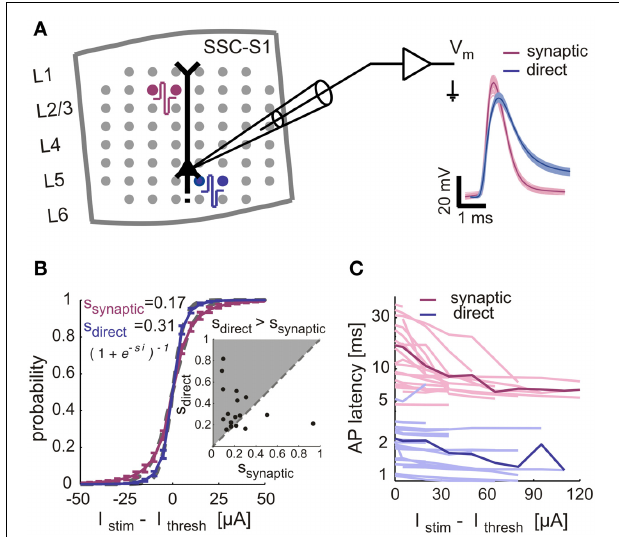
FIGURE 3 | Validation of synaptically and directly evoked neuronal responses across several and within the same neuron in cortical slices. (A) Rat somatosensory cortical slices were coupled on MEAs for extracellular stimulation, during intracellular recordings from large L5 pyramidal cells. Red and blue circles sketch the location of bipolar stimulation sites, eliciting synaptically evoked action potentials (APs) or directly evoked APs (under additional synaptic blockade). Right panel: APs recorded in the same neuron were elicited by synaptic- (magenta) and direct stimulation (blue): waveforms are aligned to their onset, bold lines indicate mean values. (B–C) IO-characteristics in intracellularly recorded neurons in cortical slices. (B) The AP response probability, for increasing stimulus intensity, is summarized across n = 28 experiments performing both direct (blue, n = 20 neurons) and synaptic stimulation (magenta, n = 20 neurons) in the same neurons: gray dashed lines show the best-fit sigmoidal functions. The same fit was repeated cell-by-cell (inset) extracting the sigmoid slope parameters (i.e., ssynaptic, sdirect) and comparing individual experiments ( n = 17 neurons) together (markers), where both stimulation types evoked responses. (C) The AP response latency, for increasing stimulus intensity, is plotted for the same data set as in (B) with thin lines representing single-cell and thick lines their average.